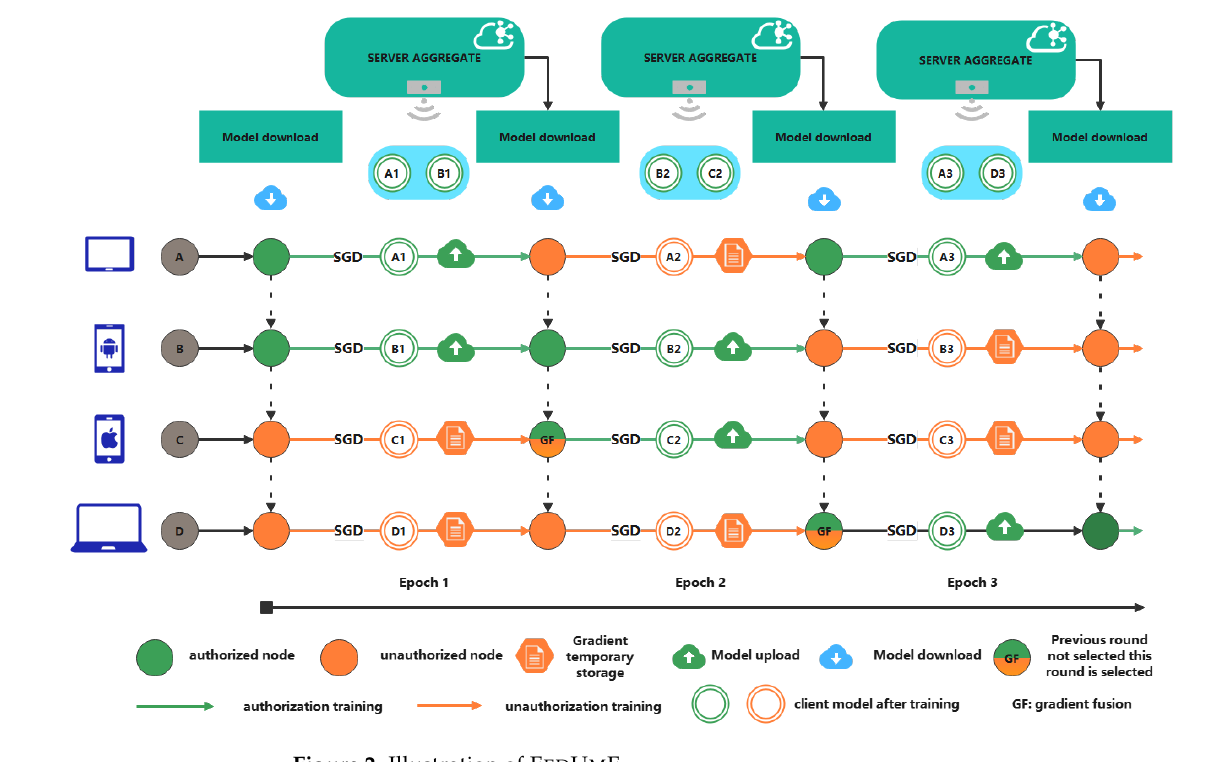
Figure 2. Illustration of F ED U M F. Algorithm 1: F ED U